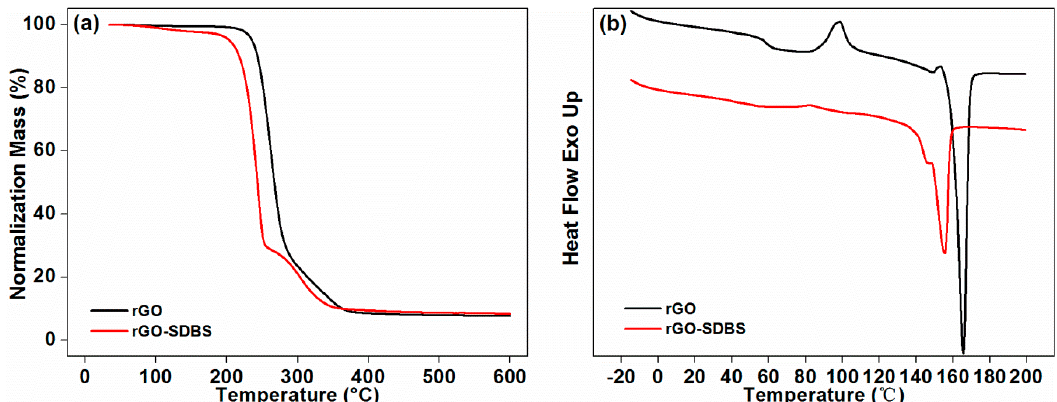
Figure 12. TGA curves ( a ) and DSC curves ( b ) of the composites before and after functionalization.